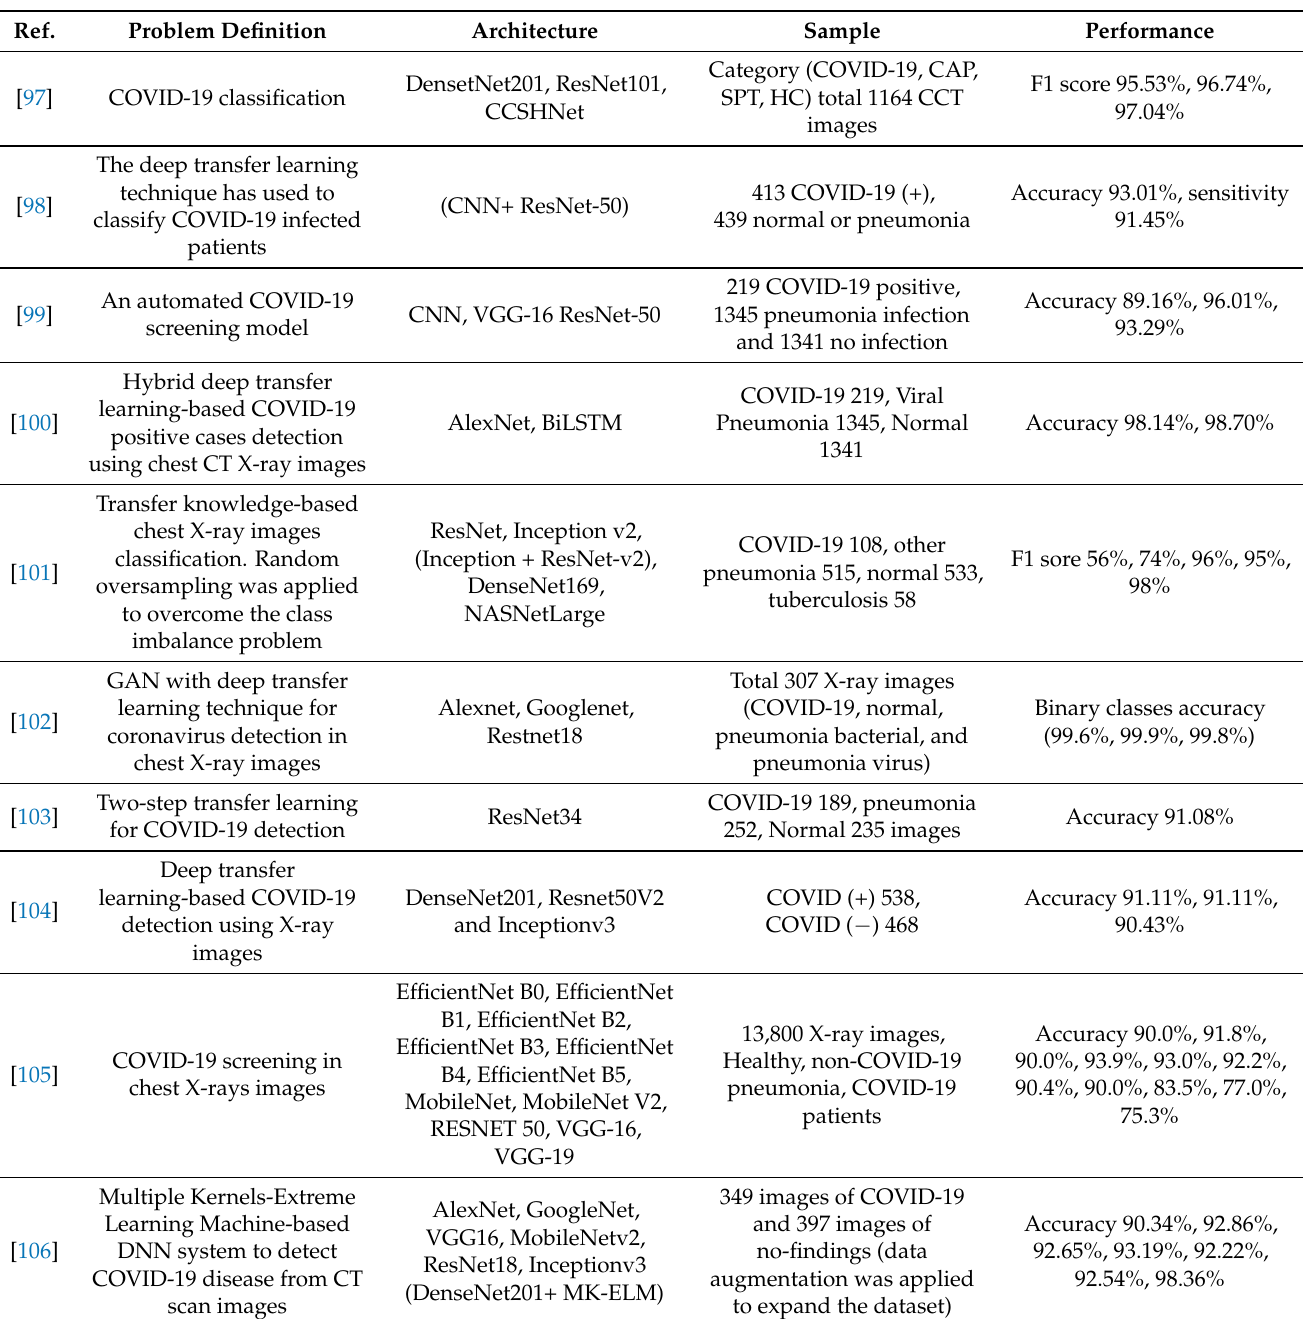
Table 3. The overview of existing transfer learning applications for COVID-19.